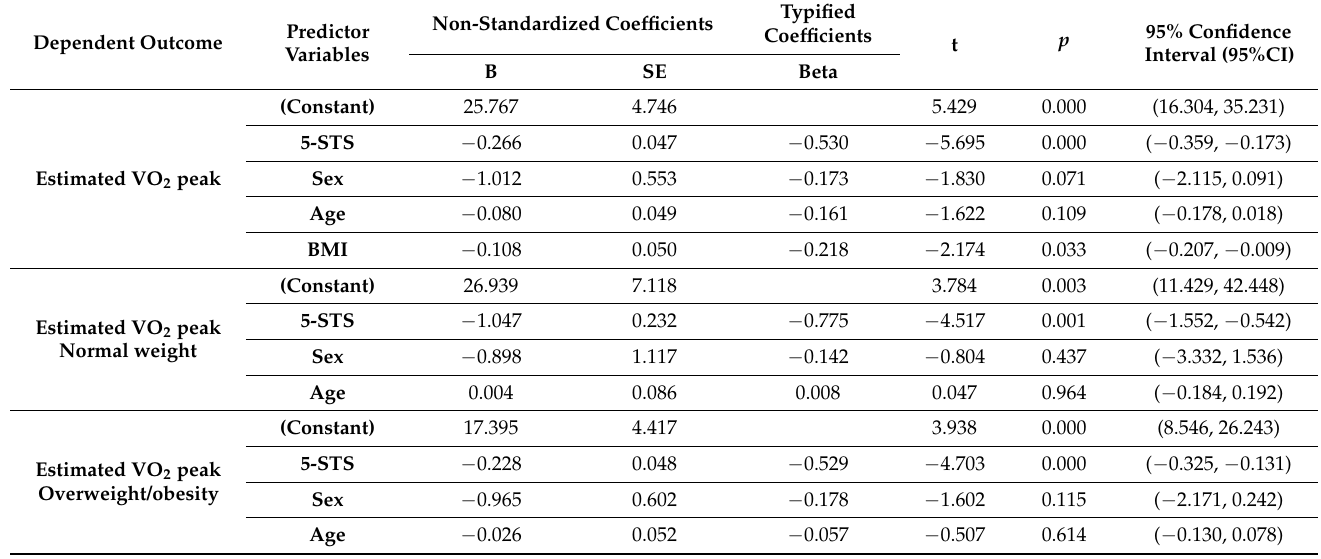
Table 4. Multivariate linear regression